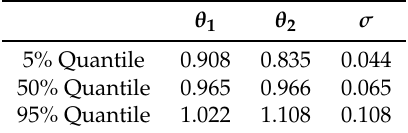
Table 3. Quantiles of posterior samples for all parameters.